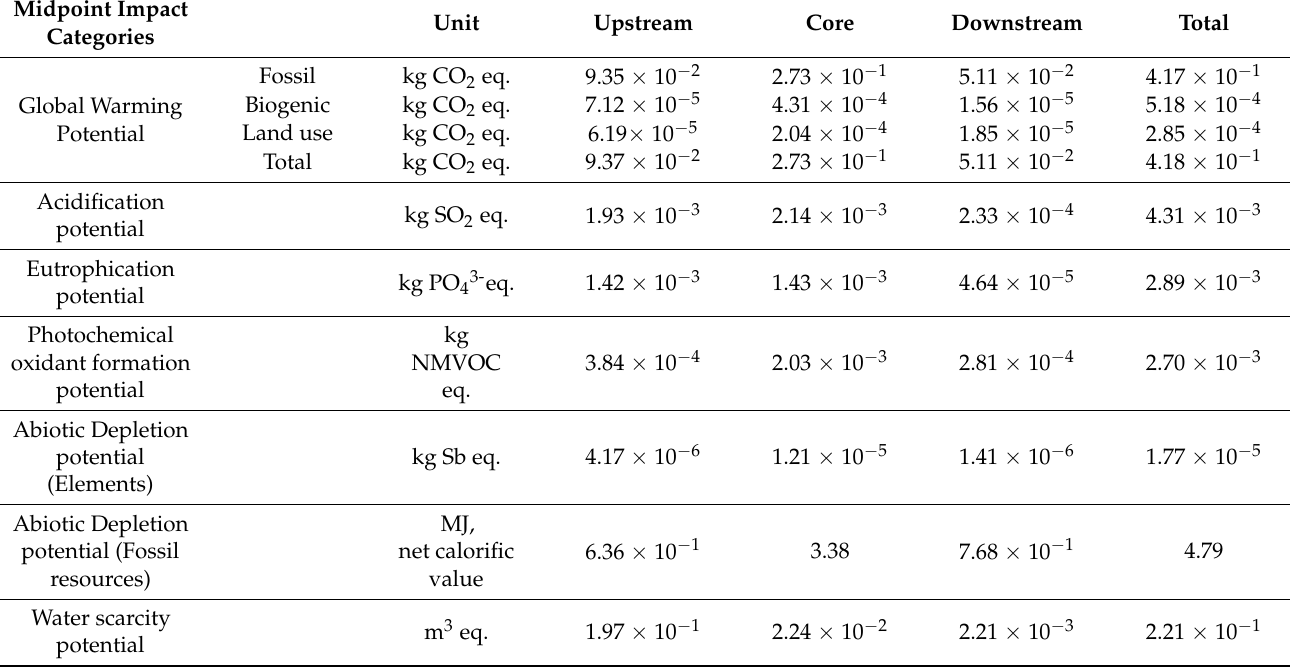
Table 8. Midpoint LCA indicators of 1 kg of durum wheat produced under organic cultivation. Source of the data: EPD International